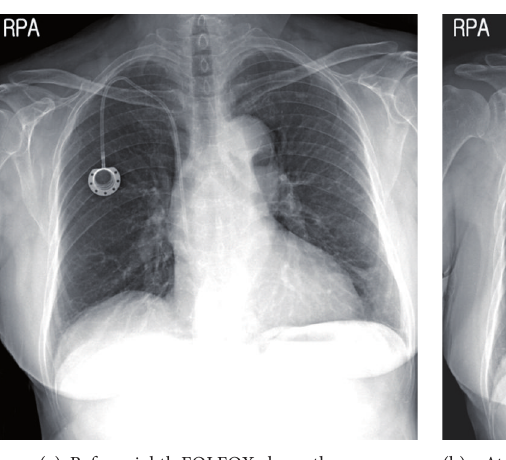
Figure 1: PET-CT after the eighth cycle of chemotherapy.